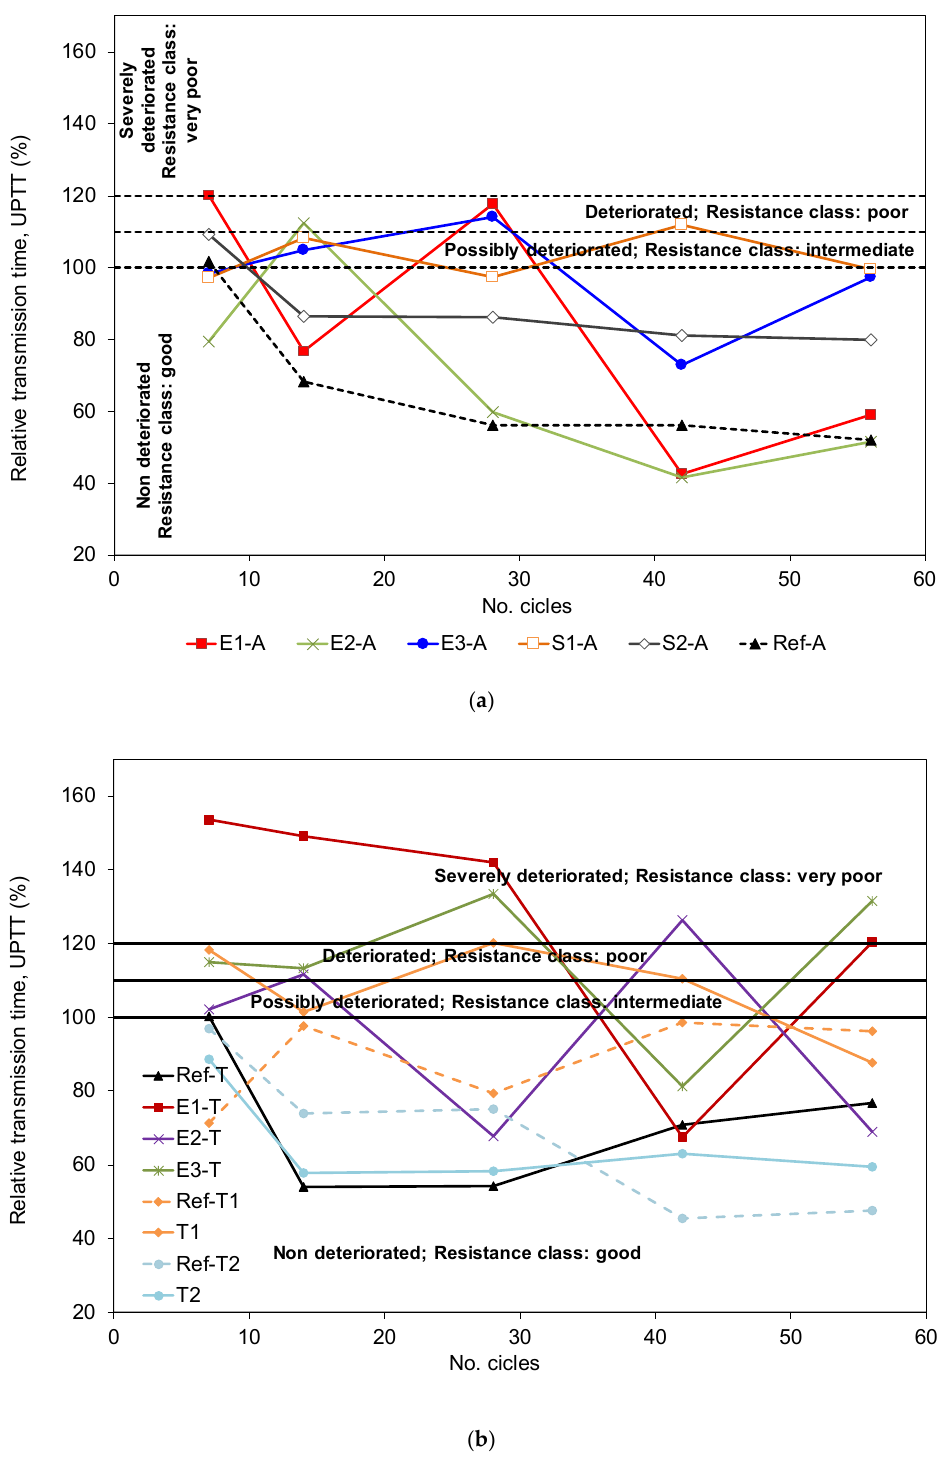
Figure 4. ( a ) Relative UPTT (%) in all ( a ) asphalt and ( b ) paving tile samples.